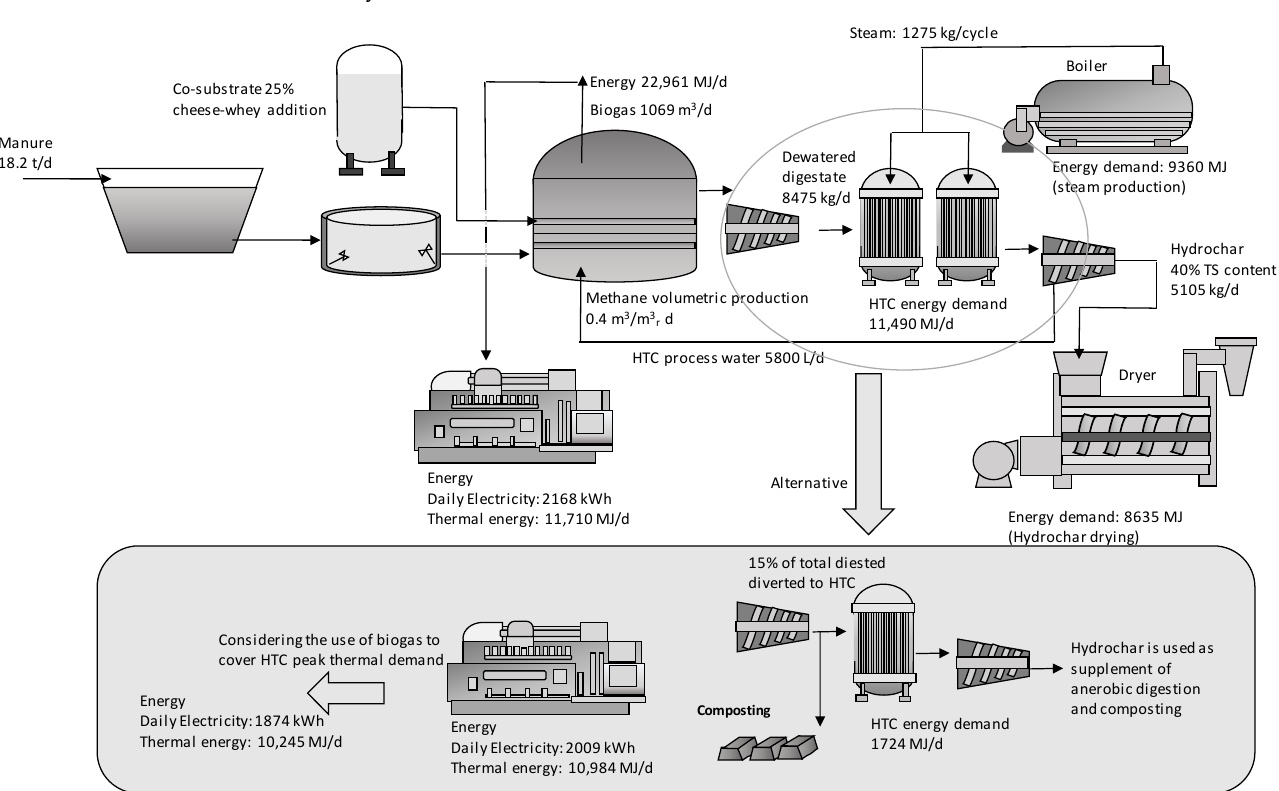
Figure 4. Representation of the main treatment stages in Scenario 2 (anaerobic digestion and subsequent HTC treatment). Cheese whey is added as co-substrate in a 25% w / w (wet weight proportion). The figure represents the main parameters of mass and energy balance when all the digestate is sent to HTC treatment, and as an alternative when only a fraction is treated by HTC (gray-colored).